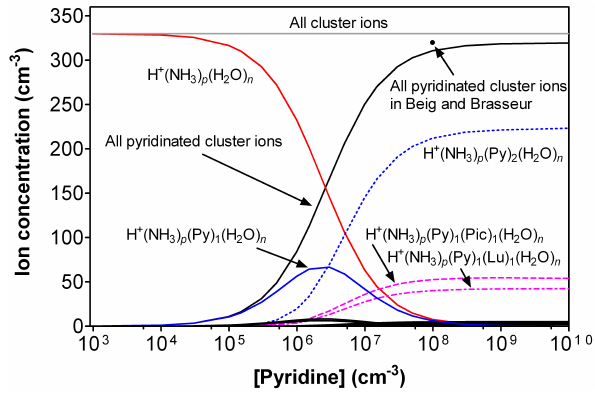
Fig. 7. Concentration of cluster ions as a function of pyridine con- centration. The values were calculated using Model A and the ini- tial concentrations are given in Table 2. The total concentration of pyridinated cluster ions in the model by Beig and Brasseur (2000) is also indicated. Py, Pic and Lu indicate pyridine, picoline and lutidine, respectively.